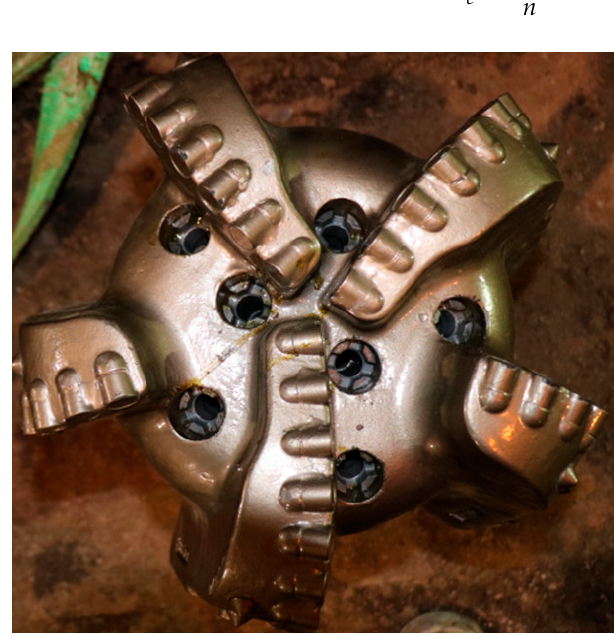
Figure 5. Front view of the PDC bit used for 3800 m depth.